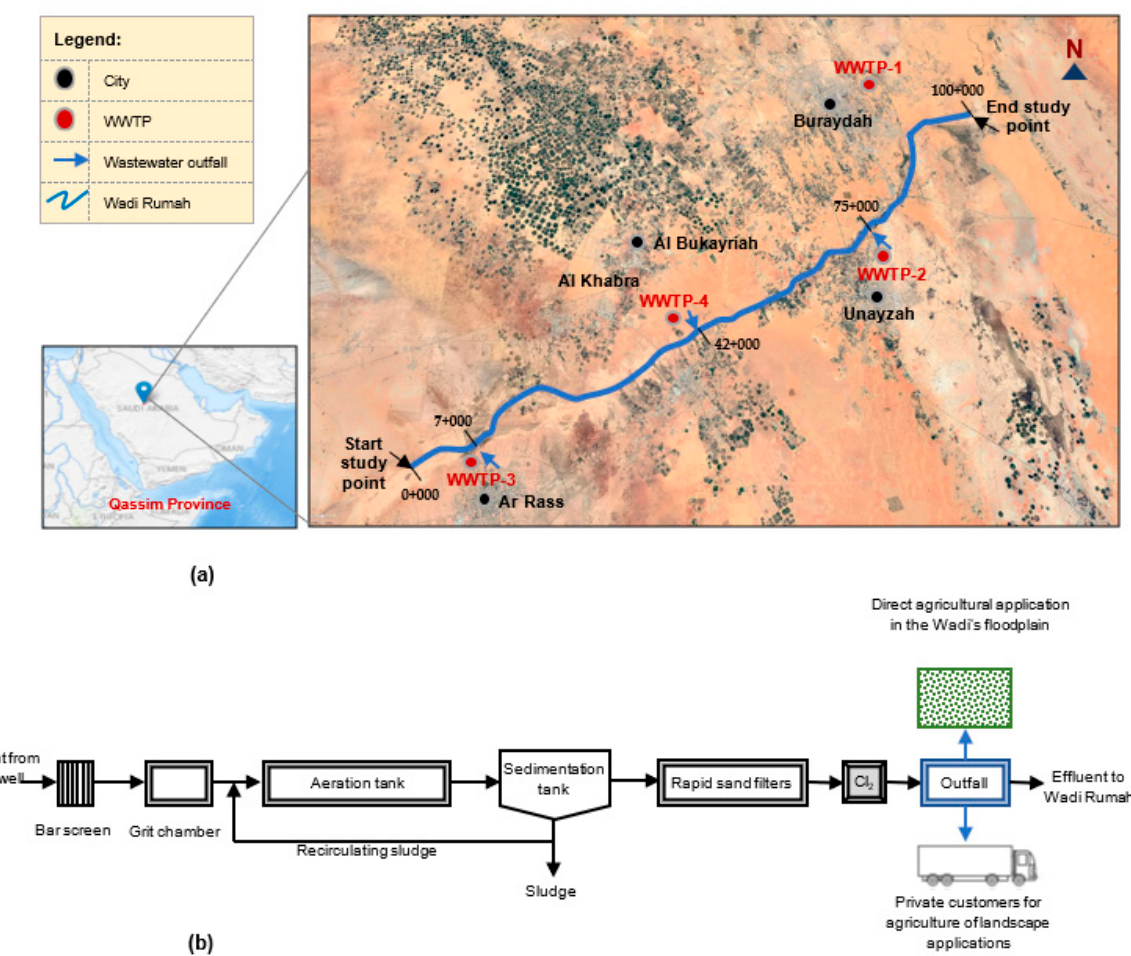
Figure 2. Study area. ( a ) Map showing location of four wastewater treatment plants discharging in Wadi Rumah (not to scale), ( b ) a typical wastewater treatment process diagram of the facilities in study area.